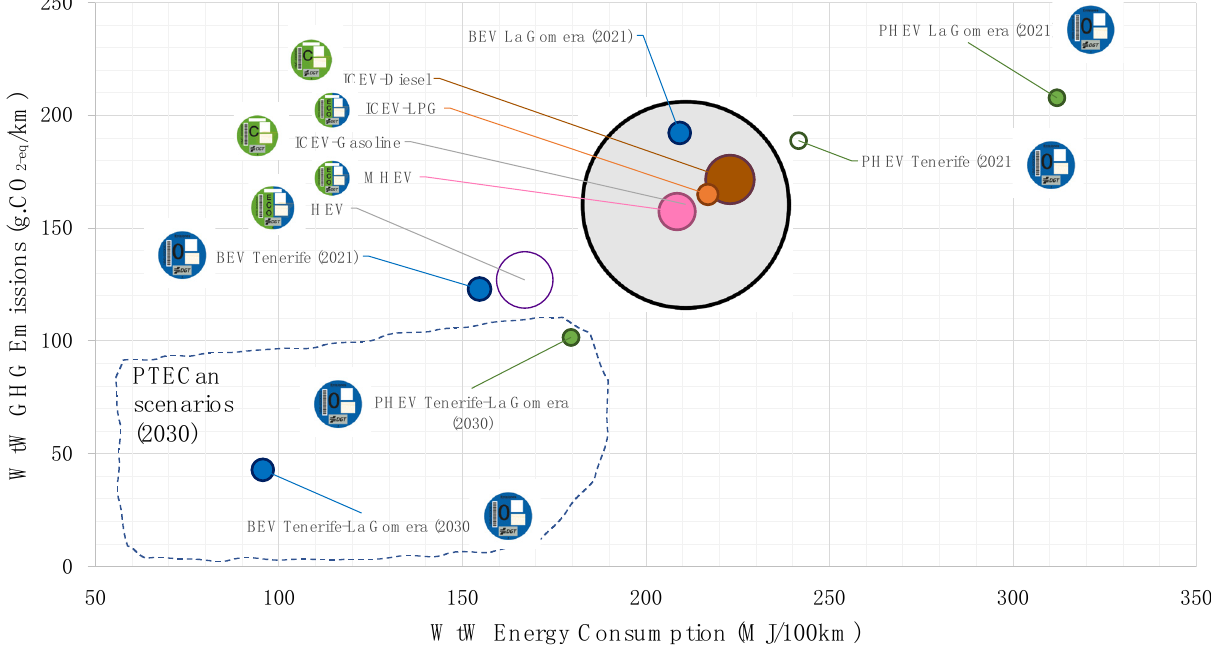
Figure 7. The global representation of results and eco-labeling correspondence.